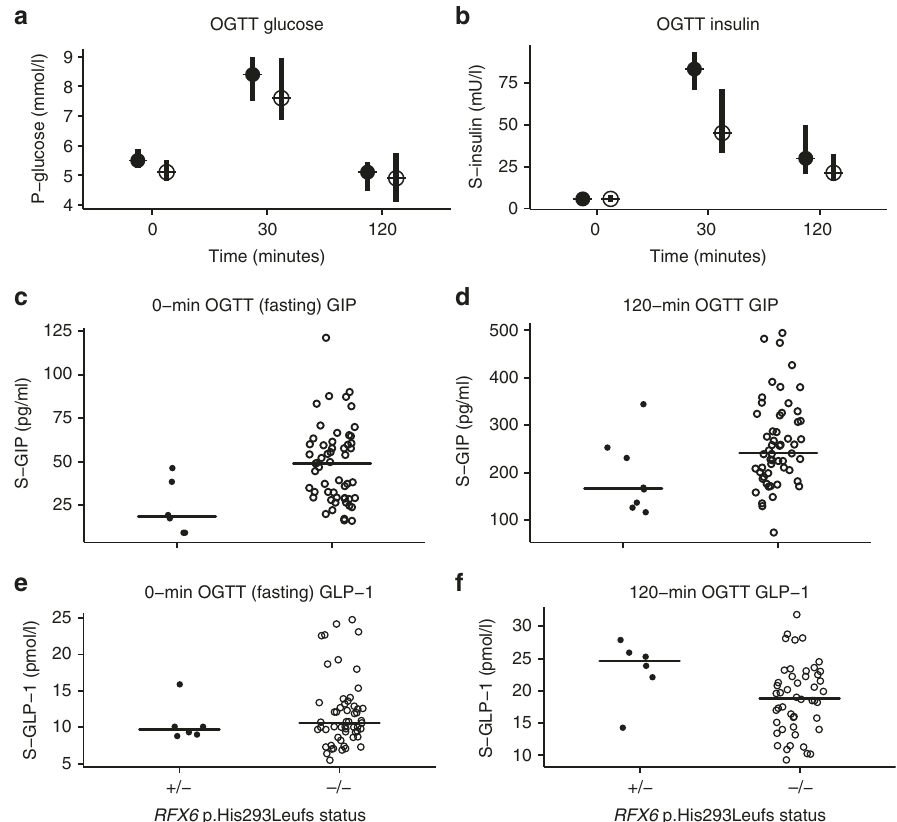
Fig. 3 Phenotypic characteristics of the Finnish RFX6 p.His293Leufs heterozygotes without diabetes. Figure shows the phenotypic characteristics at fasting and during an oral glucose tolerance test (OGTT) of the Finnish RFX6 p.His293Leufs heterozygotes without diabetes ( fi lled symbols ; n = 11) compared with population controls from the PPP-Botnia Study ( open symbols ; N = 55) matched for age, sex and BMI. a Median and interquartile range of plasma glucose concentrations during an OGTT ( N = 11 vs. 55). b Median and interquartile range of serum insulin concentrations during an OGTT ( N = 11 vs. 55). c Individual fasting GIP concentration for RFX6 heterozygotes and controls ( N = 6 vs. 55). d Individual 120-minute GIP concentration during an OGTT ( N = 8 vs. 55). e Individual fasting GLP-1 concentration ( N = 6 vs. 55). f Individual 120 min GLP-1 concentration during an OGTT ( N = 6 vs. 55). The P -values (Mann-Whitney U test) under 0.05 for the difference in a Glucose 0 min , P = 0.02; b Insulin 30 min, P = 0.015; c fasting GIP, P = 8.6 × 10 − 3 d 120- minute GIP, P = 0.029; e 120-minute GLP-1, P = 0.047; +/ − , heterozygous for RFX6 variant; − / − , controls without RFX6 variant. Horizontal black line in panels c-f represents median for each